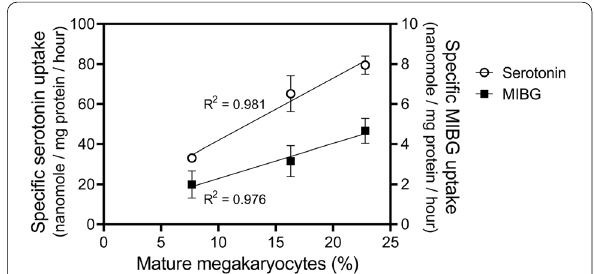
Fig.4 Relation between mature megakaryocytes and specific substrate uptake. The specific substrate uptake of serotonin (left y-axis) and MIBG (right y-axis) was plotted against the percentage of mature megakaryocytes (CD34 − /CD41a + /CD42a + /CD42b + ) in the culture batch. Data from megakaryocytic cell culture batches from three different healthy adult HSPC donors (MK1-3) are plotted (mean ±